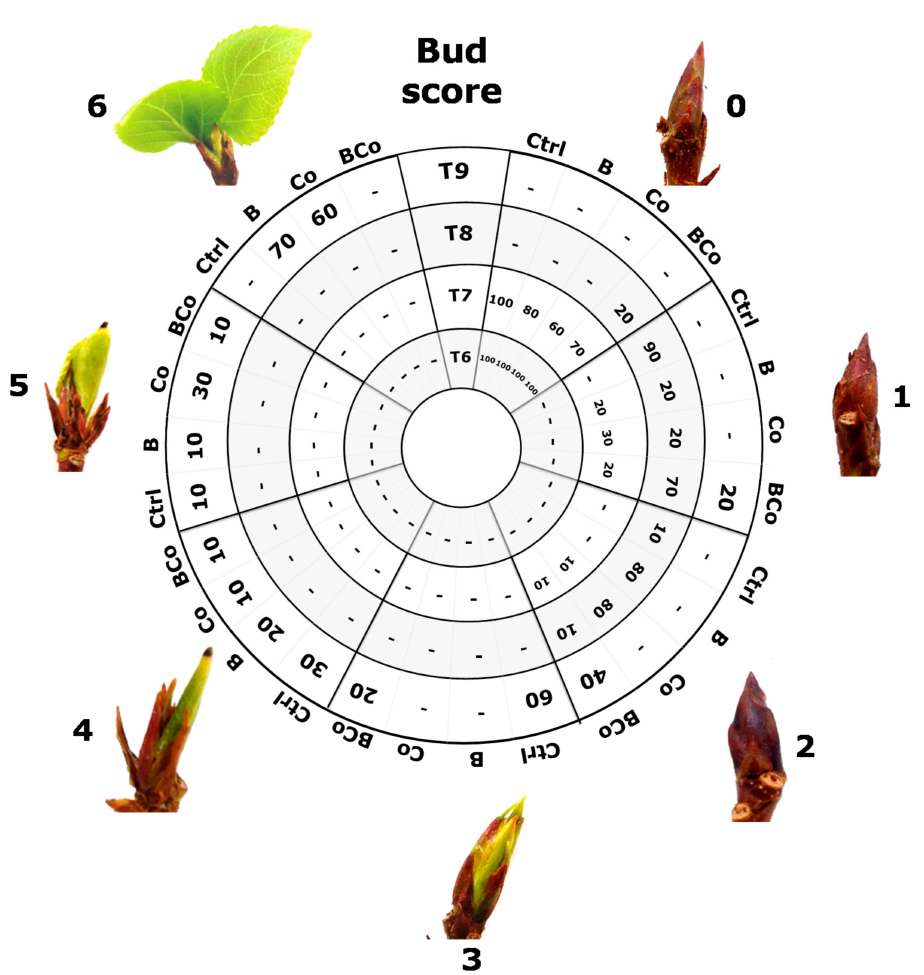
Figure 7. Evaluation of phenological stages of P. euramericana grown on four different substrates (Ctrl, B, Co, and BCo) by bud development analysis at different time points: winter dormancy condition (T6, January and T7, February), release from dormancy (T8, March), and active vegetative phase (T9, April). For each time point, the percentage of plants characterized by a specific stage of bud development is reported. Bud development was quantified using six levels of morphology score (0–6); minimal score (0) was given to the winter bud, and maximum score (6) to buds with a growing stem. Ctrl: control mix of soil and sand; B: mix of soil and sand + biochar; Co: mix of soil and sand + compost; BCo: mix of soil and sand + biochar +